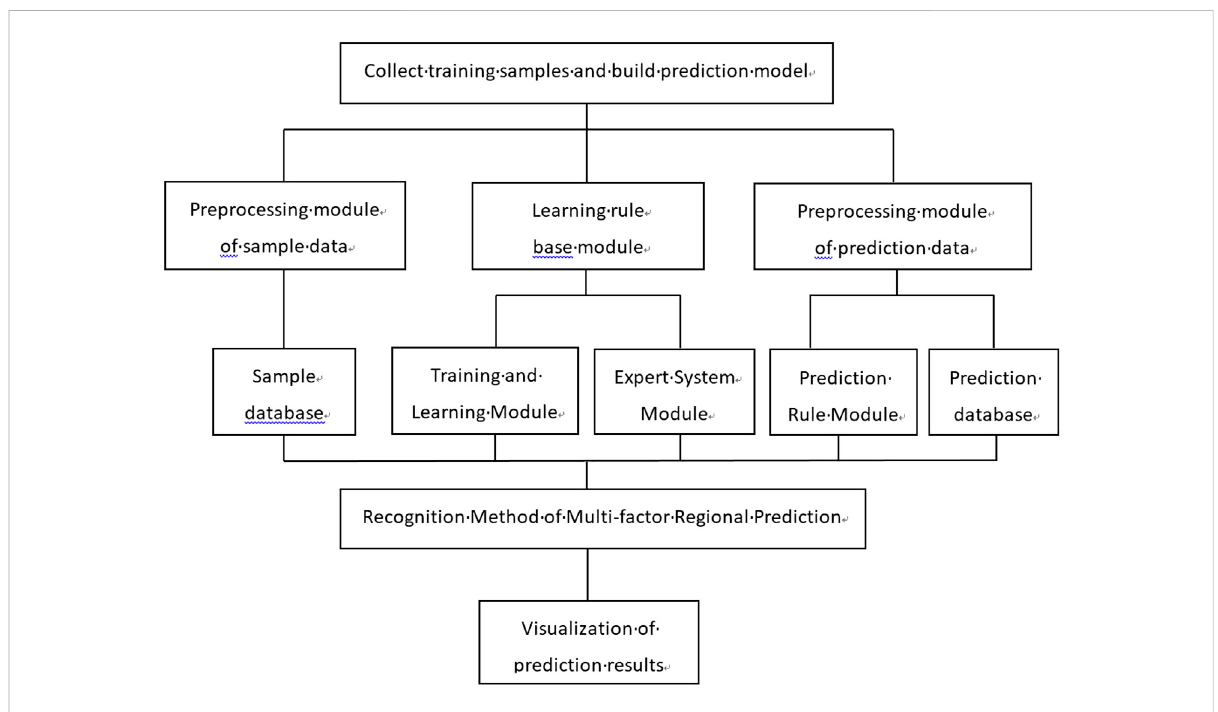
FIGURE 1 Prediction of rockburst hazard based on